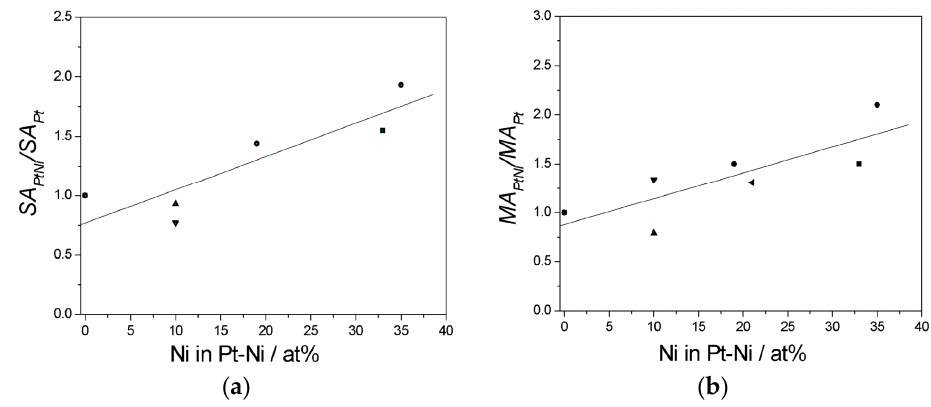
ratios in acid media on Ni content in Pt-Ni catalysts with various alloying degrees by different